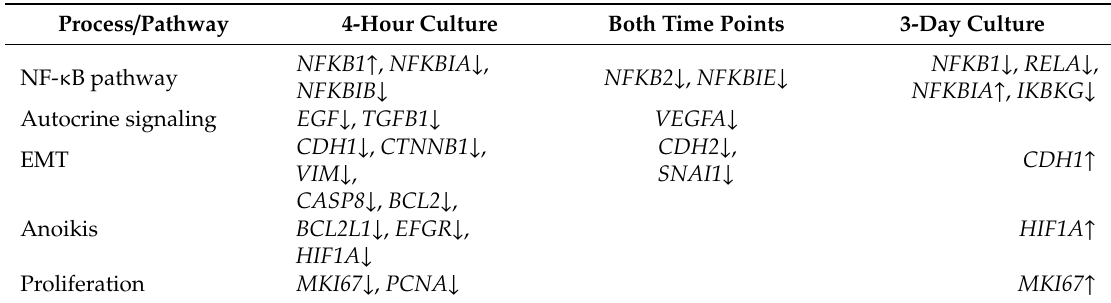
Table 1. Significant di ff erences ( p < 0.05) in mRNA synthesis of adherently growing FTC-133 cells in presence of DEX in static cell culture compared with cells grown without DEX on the RPM. Process / Pathway 4-Hour Culture Both Time Points 3-Day